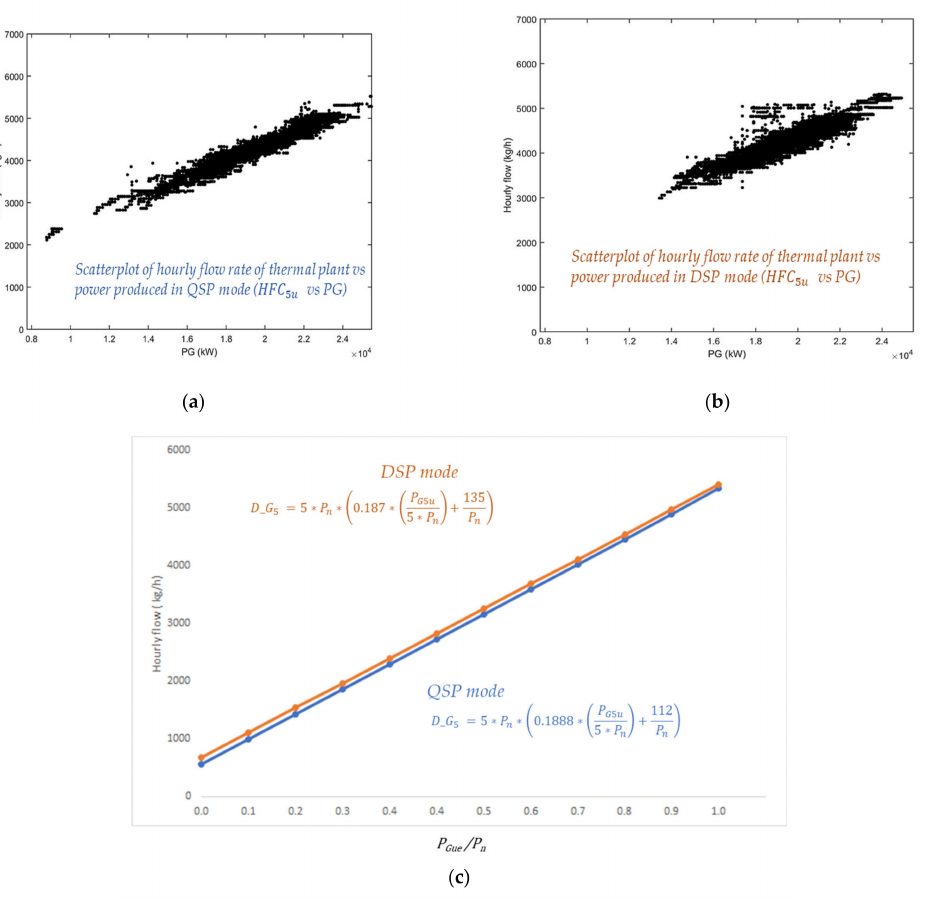
Figure 18. Behavioral models ( c ) extracted from hourly fuel flow rate measurements in QSP ( a ); and DSP ( b ); modes ( c ) behavioral models extracted from thermal plant consumption flow rate.